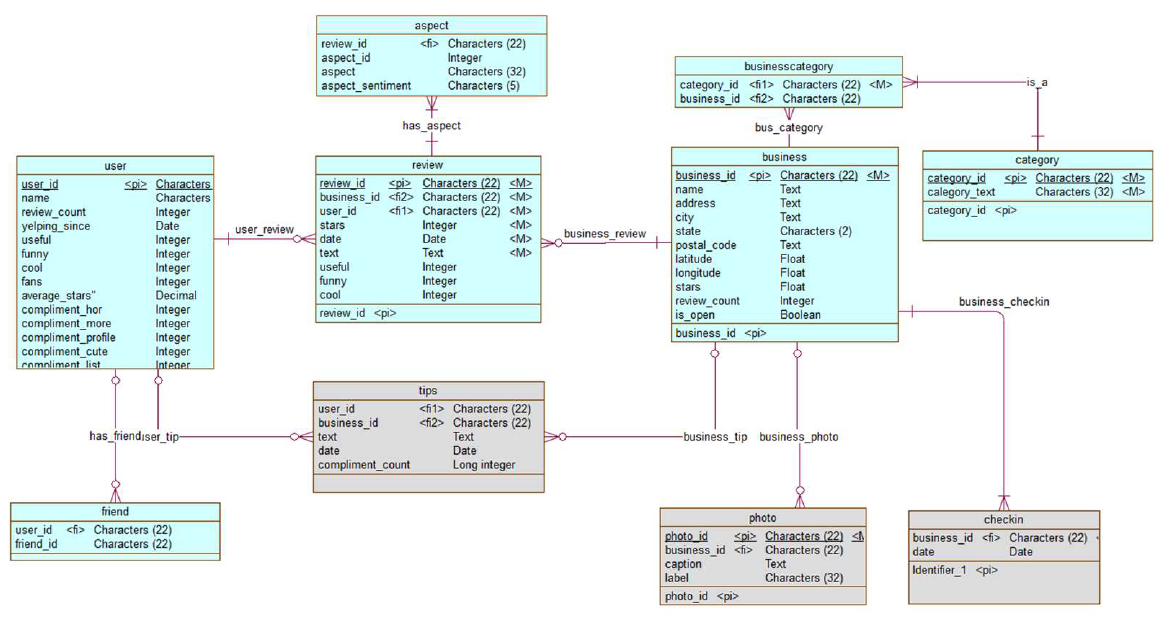
Figure 8. ERD model for analysis.